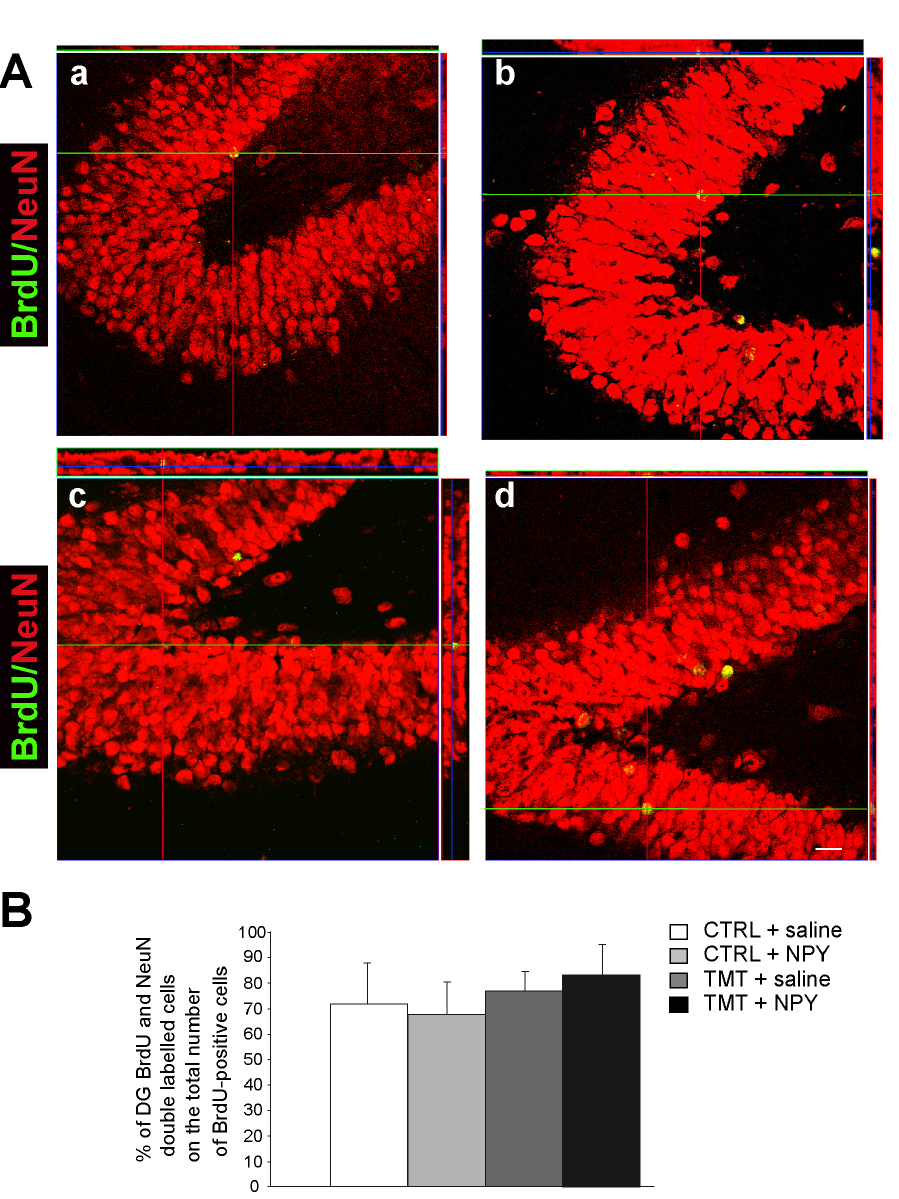
Figure 3. BrdU/NeuN double-stained cells in the DG of the different experimental groups. A . Representative confocal microscopy micrographs of CTRL + saline- (a), CTRL + NPY- (b), TMT + saline- (c), TMT + NPY (d) -treated rat DG sections double-labelled for NeuN (red) and BrdU (green): a higher number of BrdU/NeuN-positive cells is evident in TMT + NPY-treated rats (d). Scale bar: 60 m m. B . The percentage of BrdU/NeuN double-stained cells is unchanged in the various experimental groups. The values are given as means 6 S.D. (*p ,